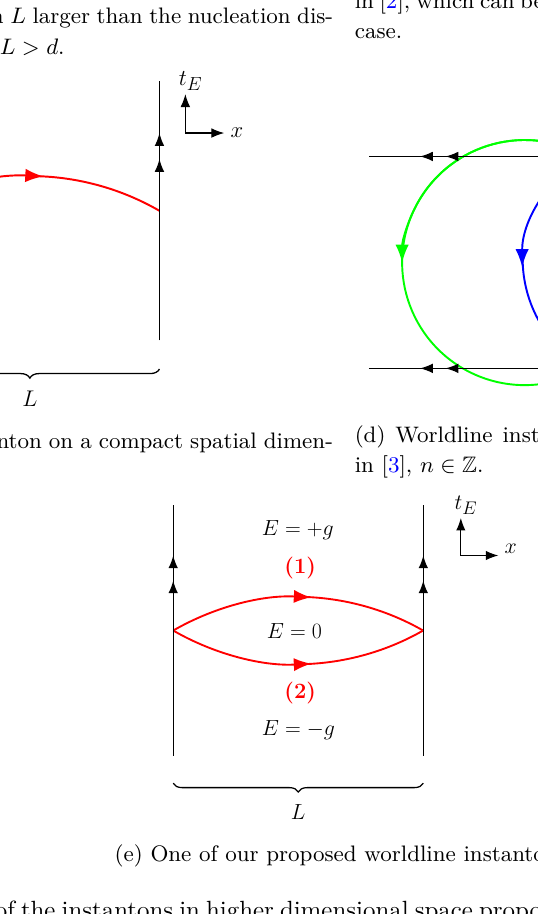
technical details about the Hilbert space cutoff on lattice and the continuum extrapolation protocol for the energy spectrum in our numerics. In appendix C, we discuss the continuum extrapolation of the prefactor c appearing in the bosonized action in section 4. Appendix D contains calculations that complement section